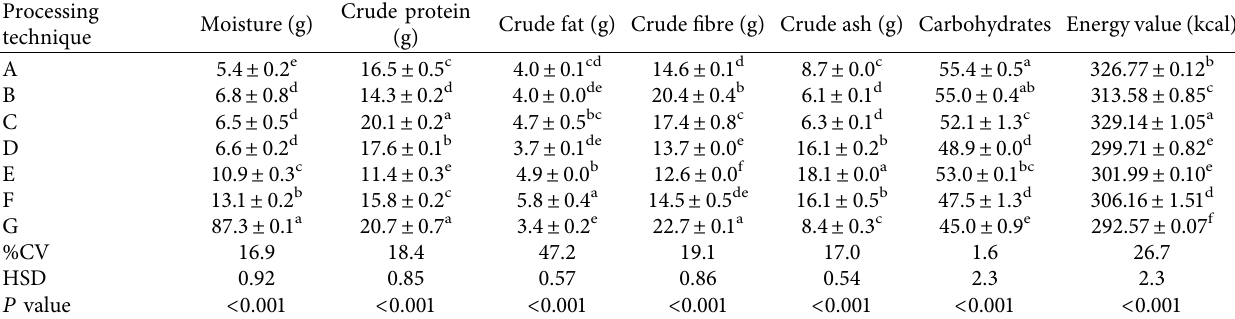
Table 10: Proximate composition of optimally dried cowpea leaves (per 100g). Processing